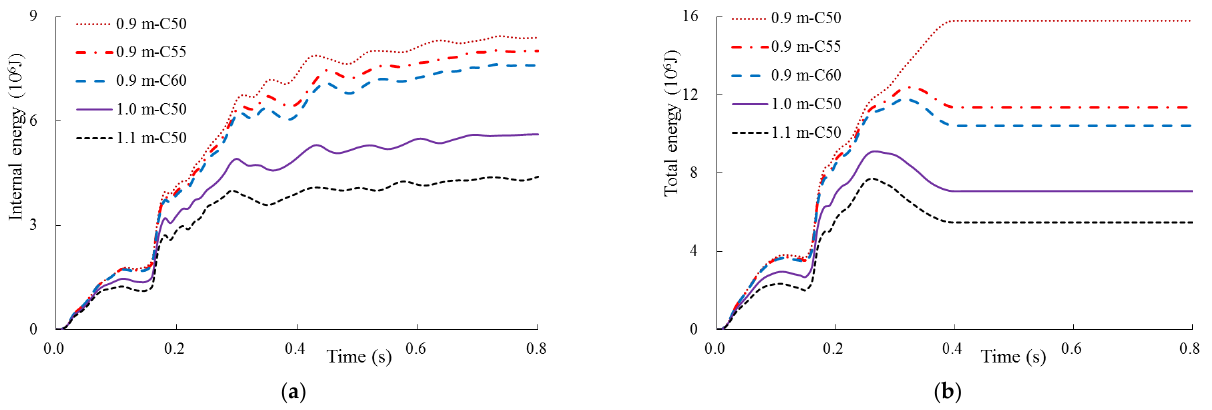
Figure 26. The internal energy of concrete and total energy of containment with different thickness and concrete strength grade. ( a ) Internal energy; ( b ) Total